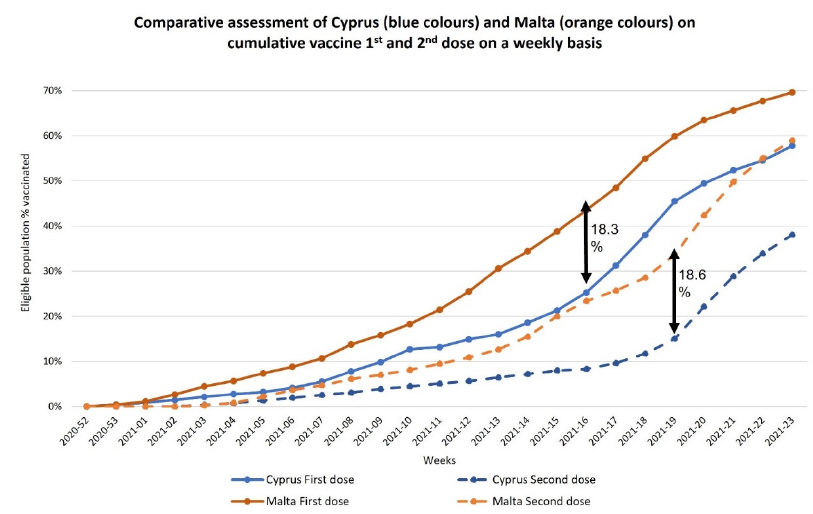
Figure 2. Comparative assessment of the cumulative vaccination population coverage in Cyprus and Malta across weeks according to the different doses.